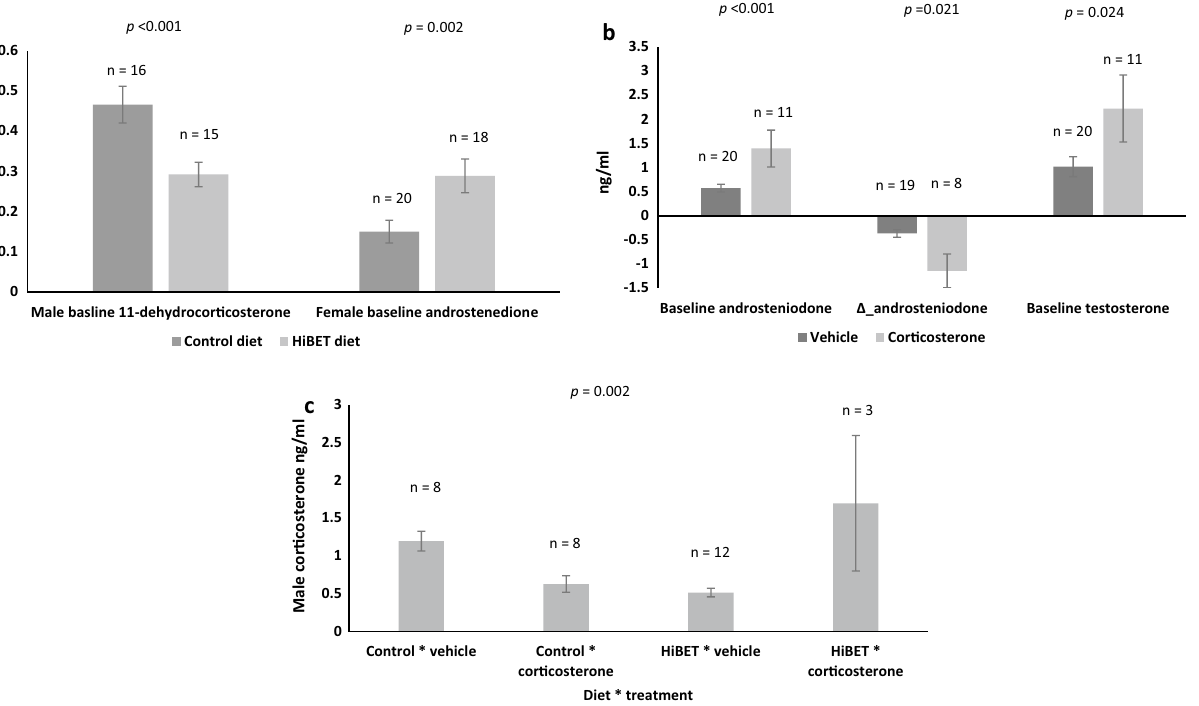
Figure 2. Circulating G 1 steroid hormones. Significance ( p ) values are indicated for each trait. ( a ) Unadjusted raw data for effect of parental diet (± s.e.m.) on G 1 male baseline level of 11-dehydrocorticosterone, and G 1 female baseline plasma concentration of androstenedione. HiBET = betaine enhanced. ( b ) Unadjusted raw data for effect of in ovo treatment (± s.e.m.) on male baseline and change (Δ) in androstenedione plasma concentrations following stressor, and baseline plasma concentration of testosterone. ( c ) Unadjusted raw data for effect of parental diet by in ovo treatment interaction (Diet*treatment) (± s.e.m.) on G 1 male baseline plasma concentration of